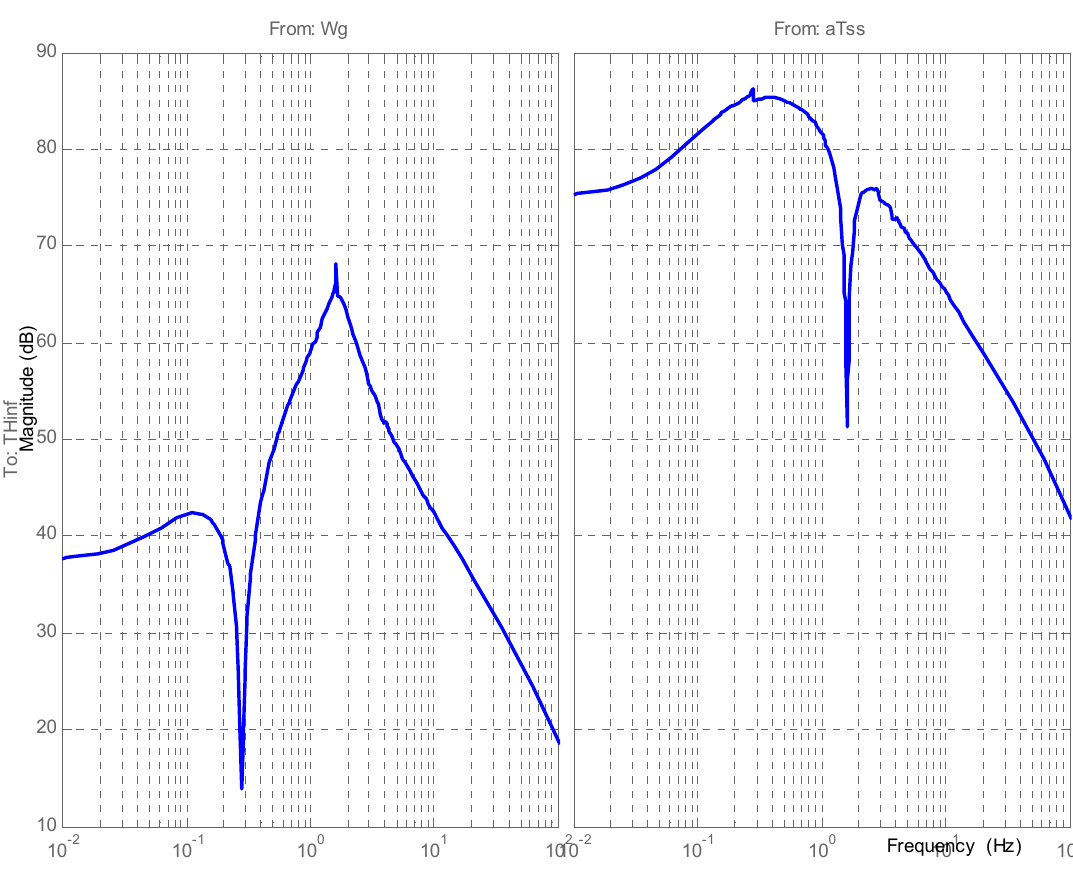
Torque Controller. ∞